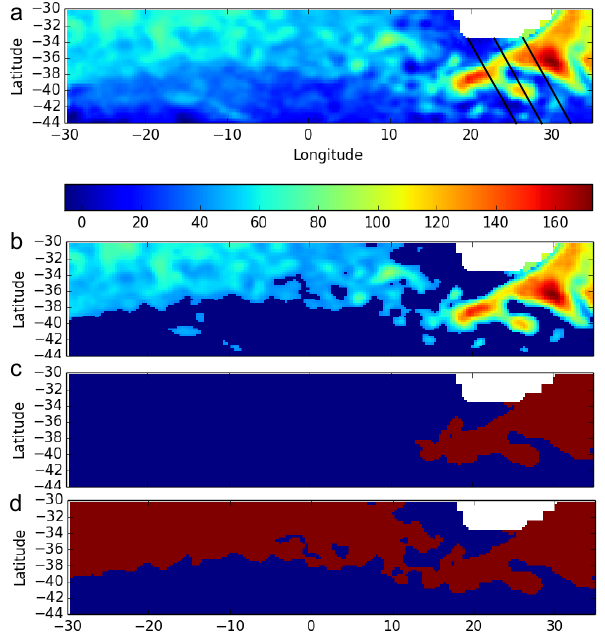
Figure 4. Selection of the limit between the ARC and the ACC using satellite ADT. (a) Initial ADT, (b) selection of the values of ADT higher than a certain threshold, (c) selection of the group of values corresponding to the Indian Ocean and (d) the extent of the Indian Ocean group for a threshold 1cm smaller, showing a jump of the red area all the way to 30 ◦ W.